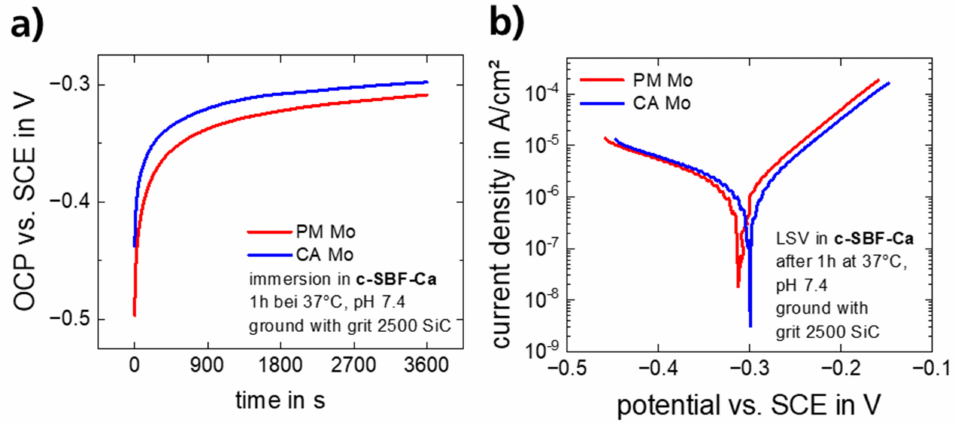
Figure 1. Representative OCP ( a ) and LSV measurements ( b ) for CA and PM Mo in c-SBF-Ca. Cell culture data are presented as mean ± SEM (standard error of the mean). At each time point in the respective cell culture experiments, untreated cells were compared to each approach by 2-sided Student’s t-test of equal variances. A p -value below 0.05 was considered as statistically